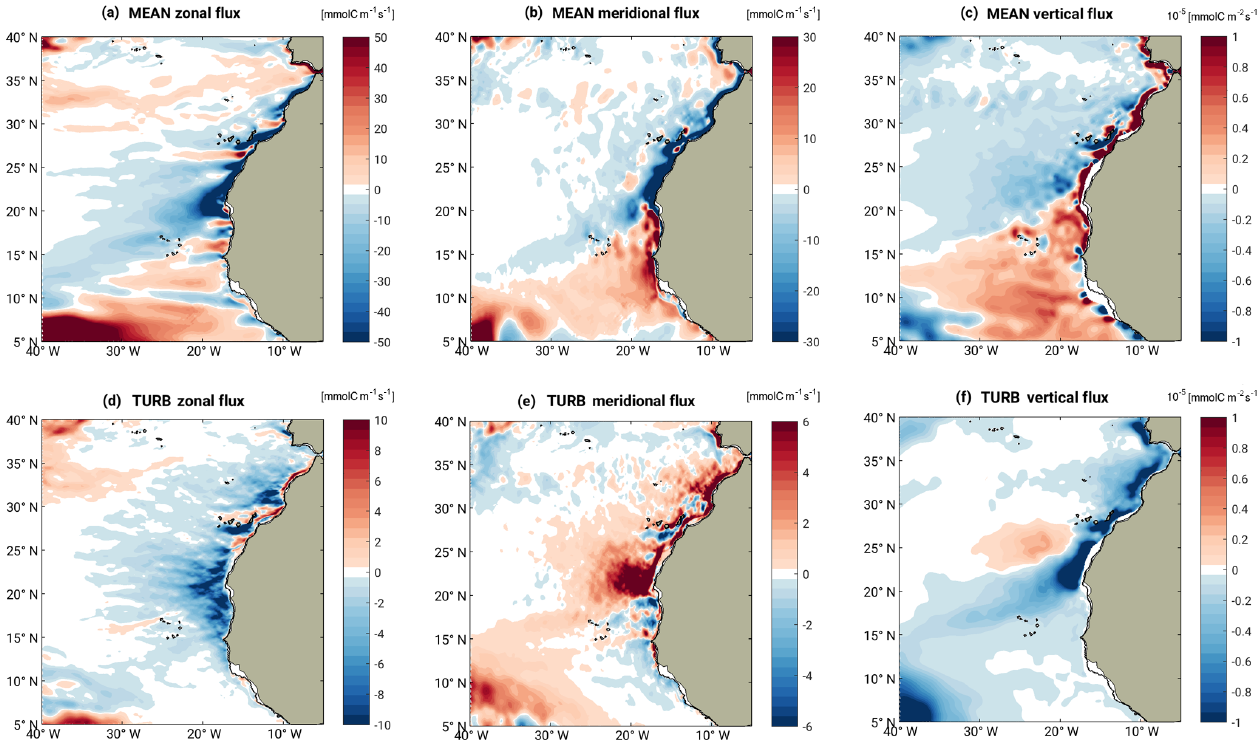
Figure 5. Reynolds decomposition of the lateral and vertical advective fluxes of C org into their average mean (cid:104) u C org (cid:105) and average turbulent (cid:104) u (cid:48) C org (cid:48) (cid:105) components, as defined in the methods section. Lateral fluxes are integrated in the first 100m depth, the vertical flux is sliced at 100m